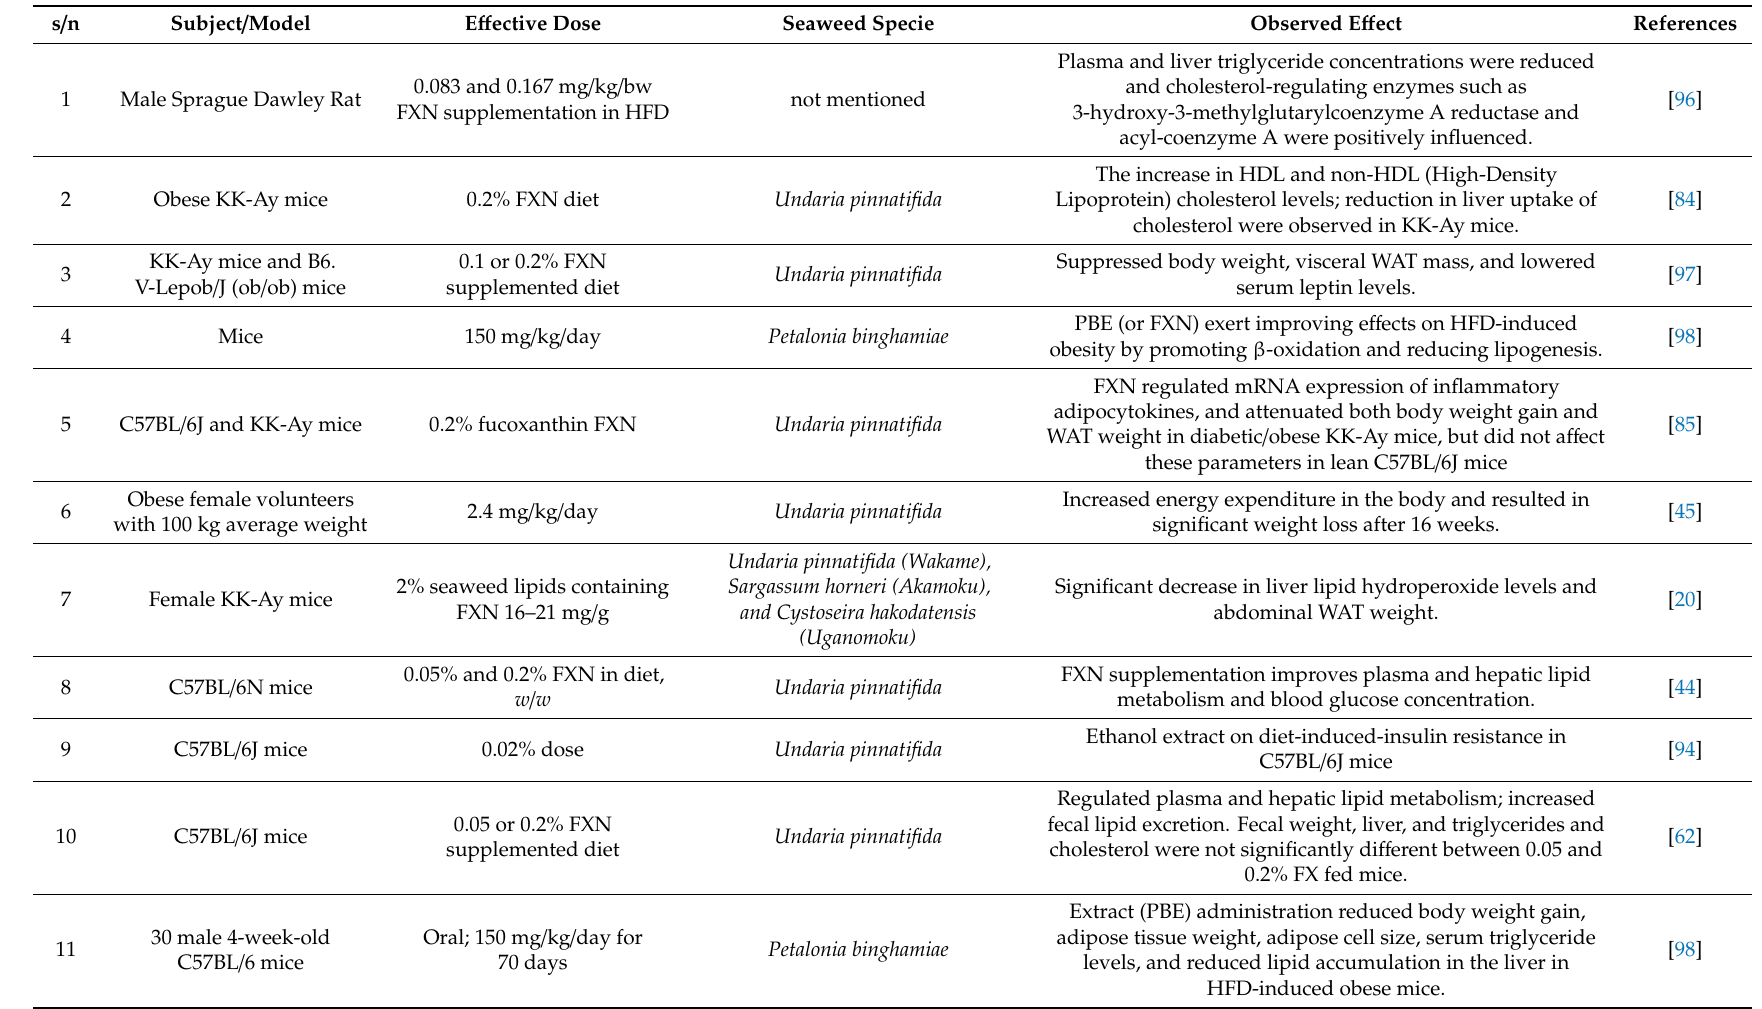
Table 1. Reported studies on the e ff ects of selected xanthophylls and their anti-obesity e ff